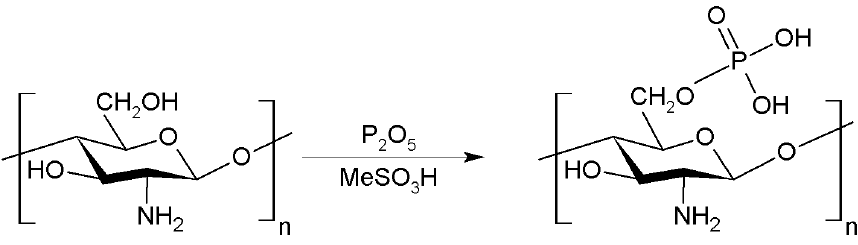
Figure 8. Phosphorylation of chitosan using P 2 O 5 .